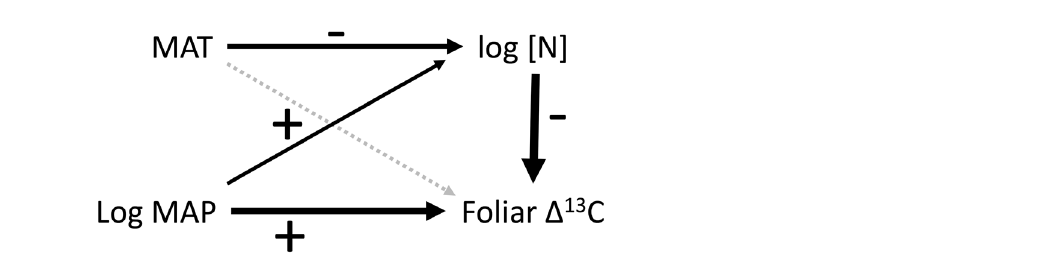
Figure 5. Path diagram illustrating standardized effects (either positive or negative) of mean annual temperature (MAT), mean annual precipitation (log transformed MAP), and foliar N concentration (log transformed) on carbon isotope discrimination in leaves (Foliar Δ 13 C). Arrow widths are proportional to effect sizes; black arrows denote significant